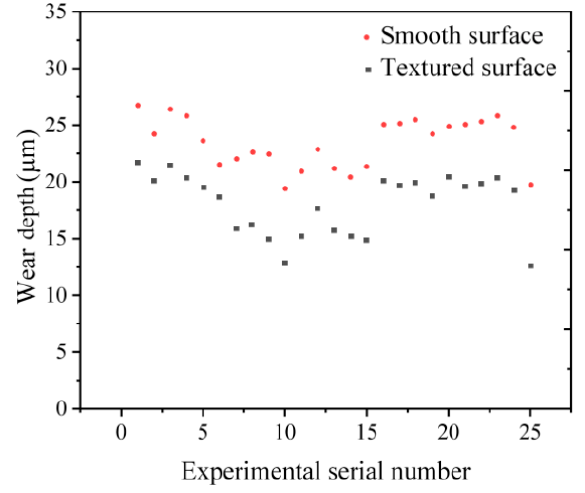
Figure 2. Comparative analysis of wear under two conditions.